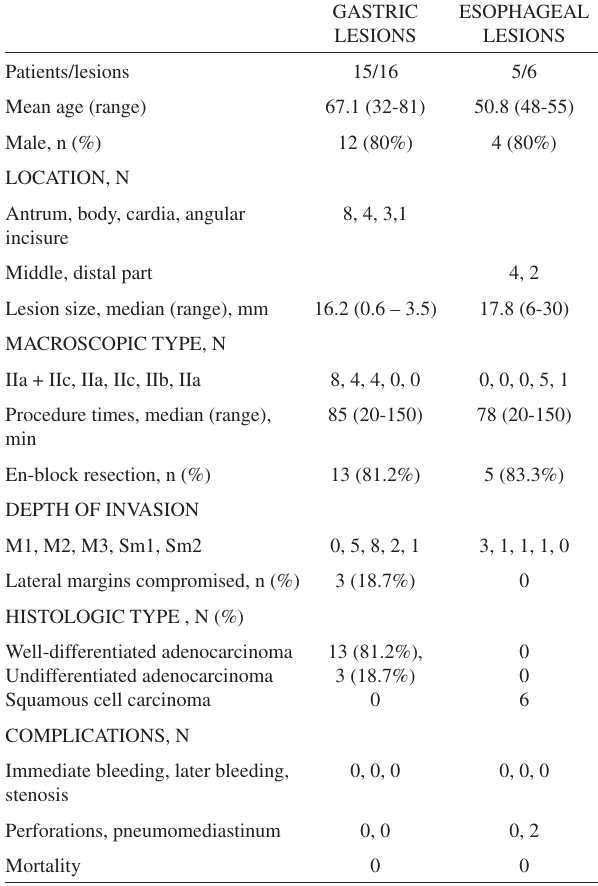
Table 3 - Clinicopathological